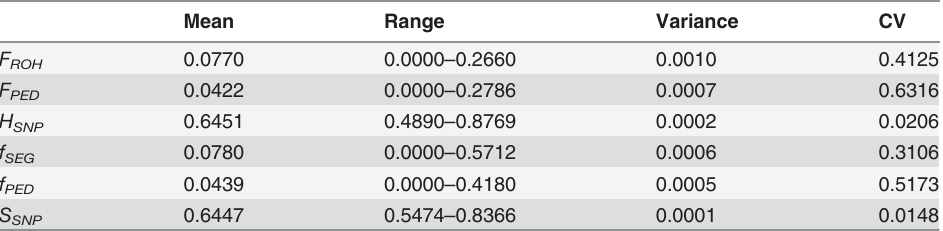
Table 1. Mean, range (minimum and maximum values), variance and coefficient of variation (CV) for different estimates. Mean Range